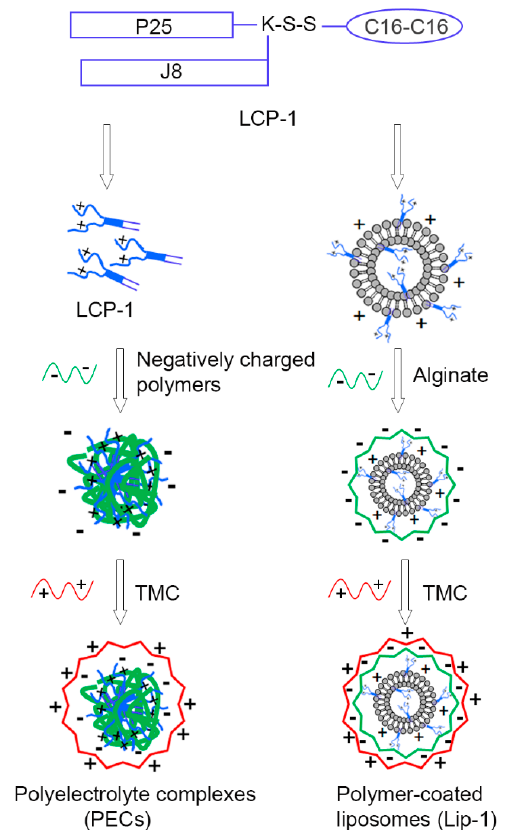
Figure 1. Schematic illustration of delivery systems designed for LCP-1: polyelectrolyte complexes (PECs) and polymer-coated liposomes. PECs were produced by mixing LCP-1 with negatively charged polymer, then coated with positively charged trimethyl chitosan (TMC); while polymer-coated liposomes were produced by encapsulating LCP-1 into liposomes, followed by coating with alginate and TMC. C16: lipid moiety 2-amino- D , L -hexadecanoic acid, J8: B cell epitope derived from GAS M protein (QAEDKVKQSREAKKQVEKALKQLEDKVQ), P25: universal T helper epitope